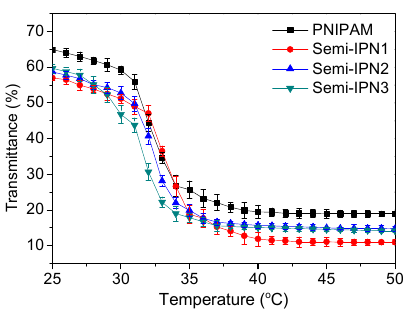
Figure 9. Transmittance of the PNIPAM and semi-IPN microsphere suspensions in different temperatures at pH 7.0.